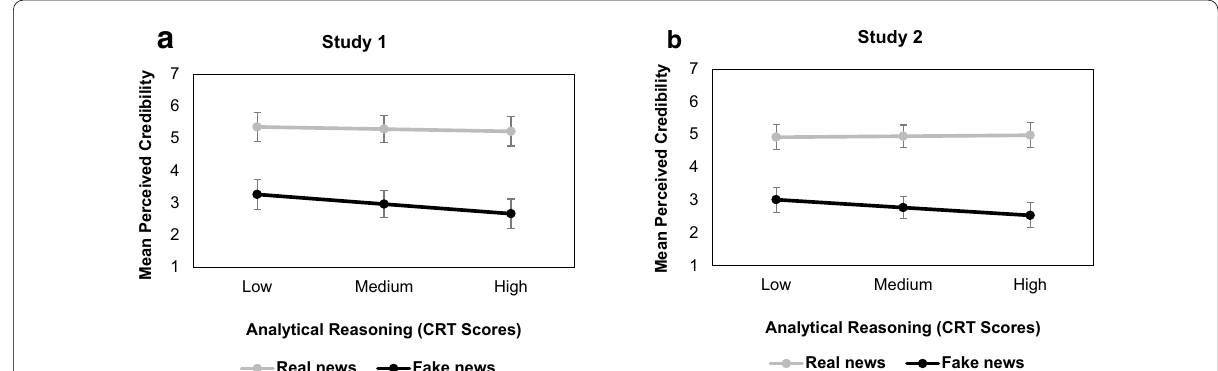
Fig. 3 Mean perceived credibility rating (1 Not at all credible to 10 Completely credible ) for real (gray line) and fake (black line) news articles across = = levels of analytical reasoning (continuous; indexed by Cognitive Reflection Test (CRT) scores) in Study 1 (Panel A) and Study 2 (Panel B). Error bars denote standard errors. The medium analytical reasoning level indicates the mean CRT score in the current sample while the low and high levels indicate 1 SD below and above the mean CRT score, respectively. Note that the y-axis ranges from 1 to 7 to reflect the actual range of responses given by participants. Consistent across both studies, perceived credibility for real news was not influenced by levels of analytical reasoning, while higher analytical reasoning was associated with less perceived credibility for fake news